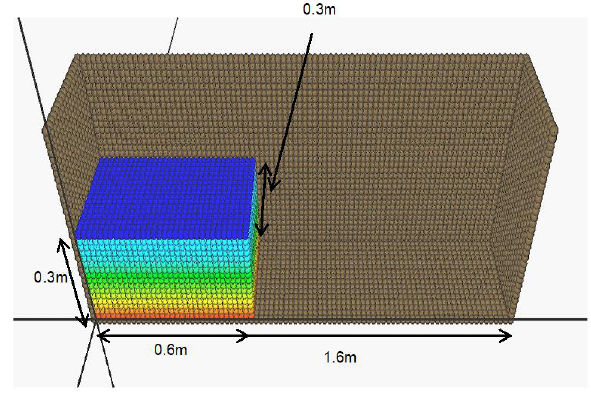
Fig. 11. Hydrostatic pressure distribution in depth direction.